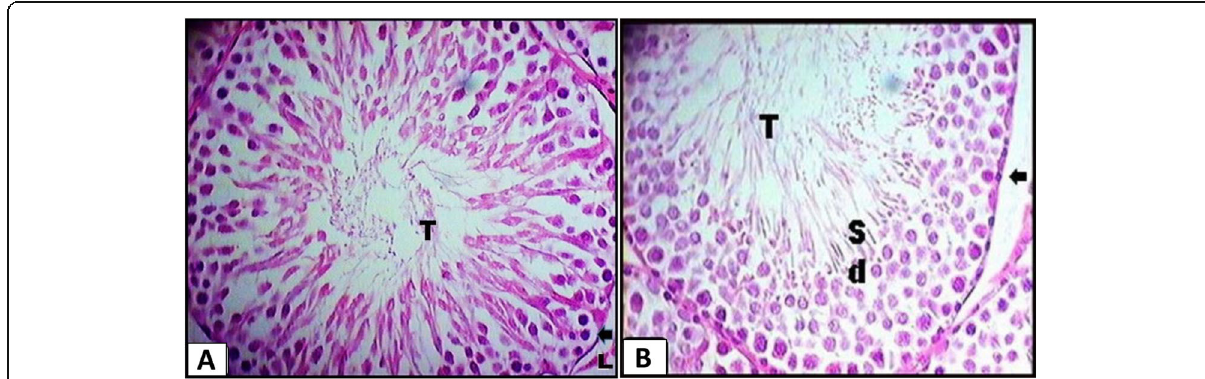
Fig. 1 a A photomicrograph of a C.S. in the testis of control group showing normal seminiferous tubule with rounded, regular outline (arrow), normal spermatogenic cells formed of 4 – 6 layers at different stages of spermatogenesis. The interstitial spaces show Leydig cells (L) and normal. Notice the appearance of sperm flagella (T). H&E (× 400). b A photomicrograph of C.S. of seminiferous tubule from rat fed sesame group II showing the lining germinal epithelium (arrow), regularly rounded seminiferous tubule has several layers of cells in different spermatogenesis stages with spermatids (d), abundant sperm (s), and crowded flagella (T) filling their lumen. H&E (× 400)